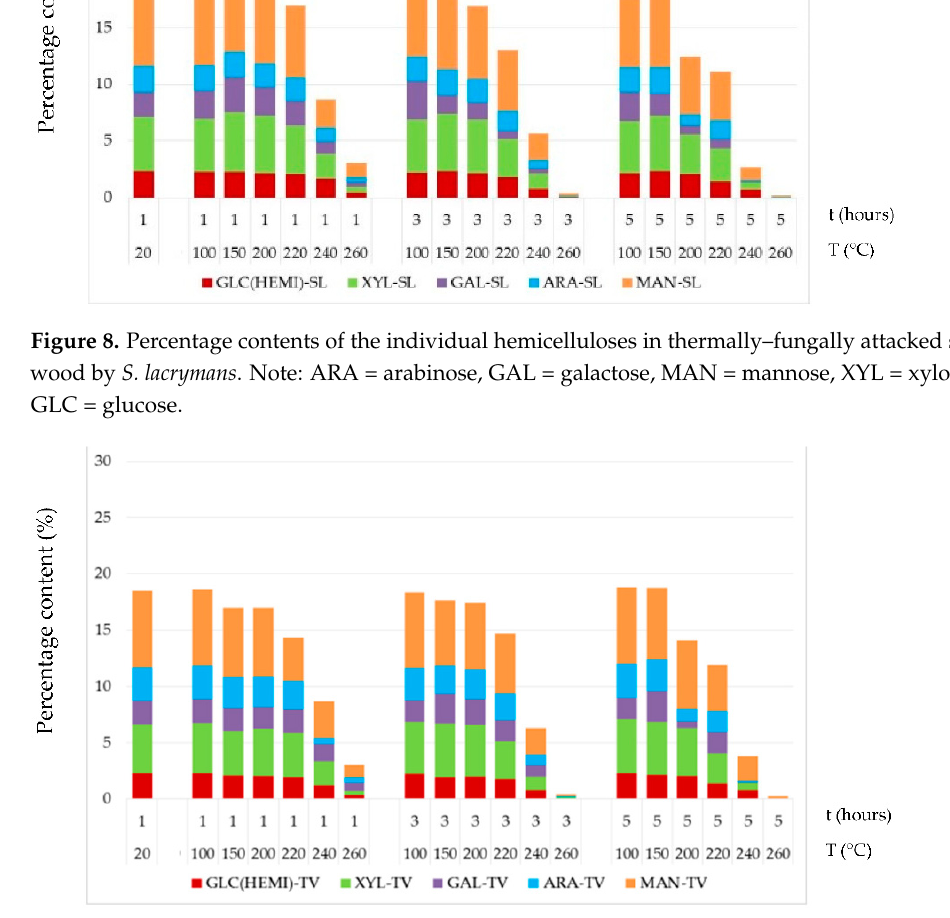
Figure 9. Percentage contents of the individual hemicelluloses in thermally–fungally attacked spruce wood by T. versicolor . Note: ARA = arabinose, GAL = galactose, MAN = mannose, XYL = xylose and GLC = glucose.